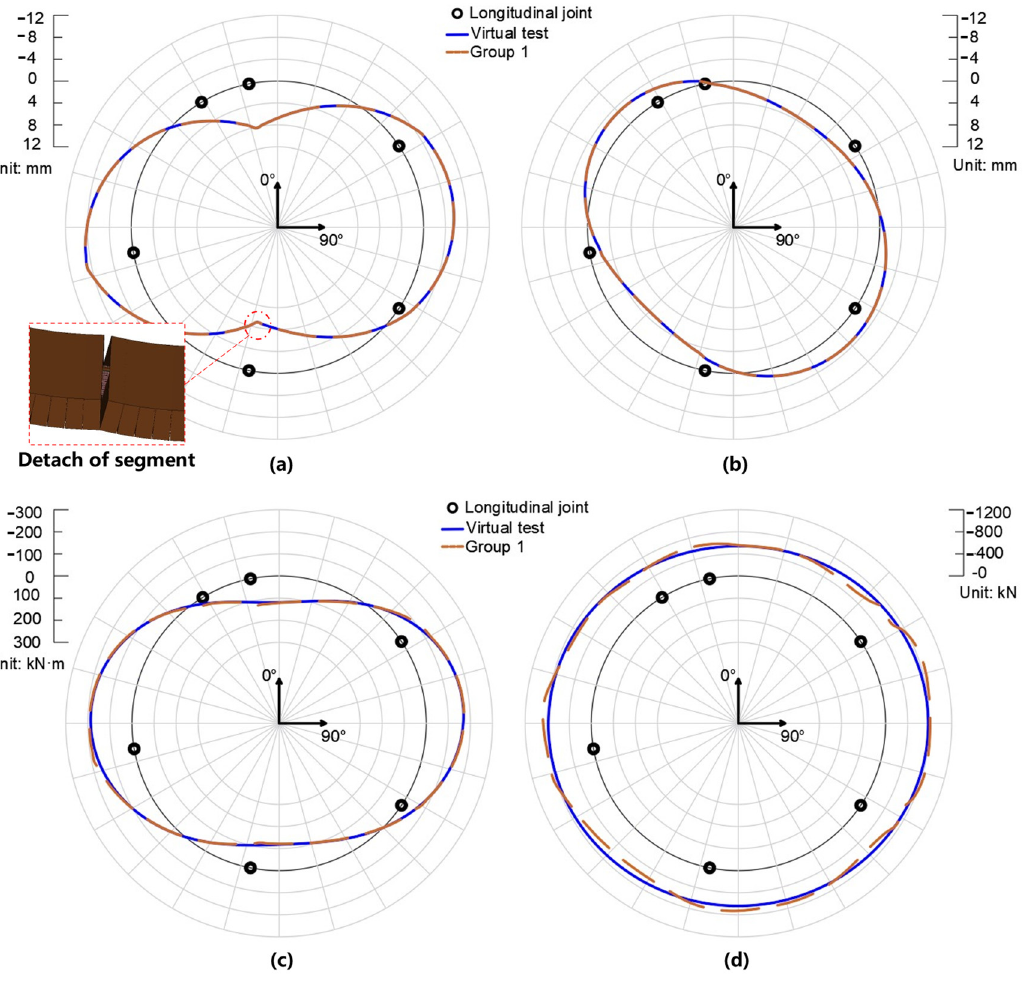
Figure 5. The radial displacement ( a ), tangential displacement ( b ), bending moment ( c ), and axial force ( d ) of virtual test and Group